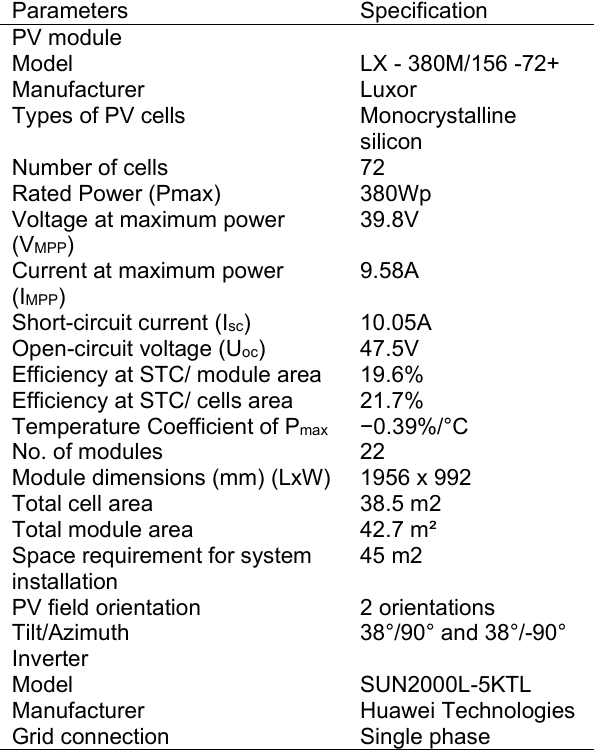
Figure 4. The single line diagram of the grid- connected PV system Table 2. Main equipment of the grid connected PV system.